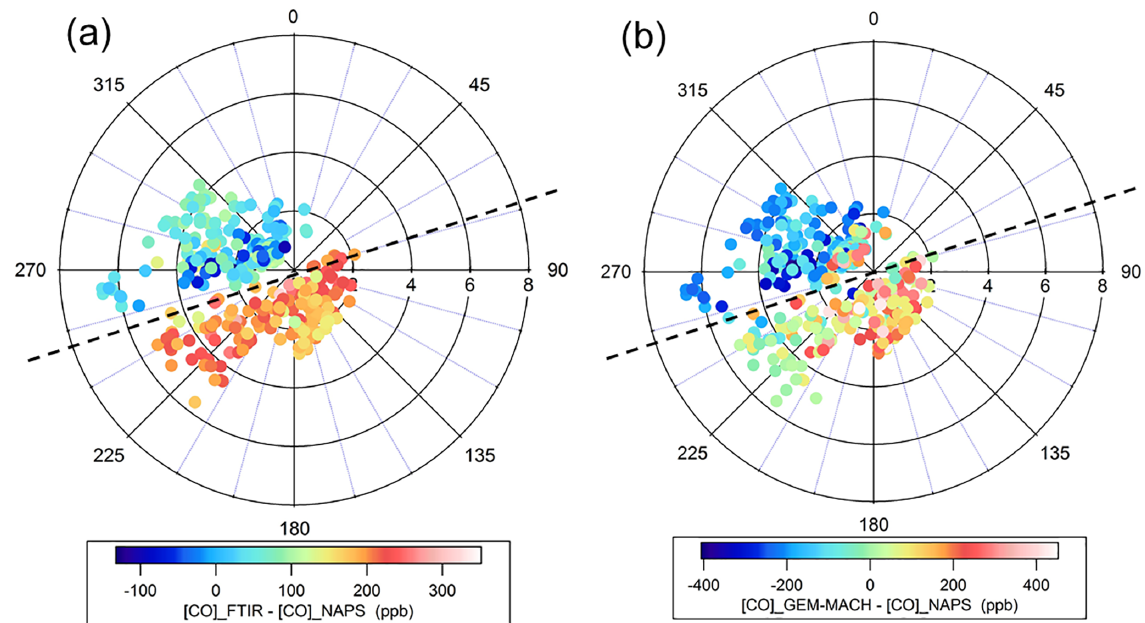
Figure 4. Polar plots of CO mixing-ratio difference between measurements from the FTIR spectrometer and NAPS (a) and between GEM- MACH output and NAPS measurements (b) . Azimuth angle represents wind direction (meteorological convention: 0 ◦ = wind from north, 90 ◦ = wind from east, etc.), and radius indicates wind speed (ms − 1 ) . The colour shows the CO mixing-ratio difference. The centre corre- sponds to the location of the NAPS trailer. The black dashed line shows the orientation of the highway: above this line, the wind came across the highway to the